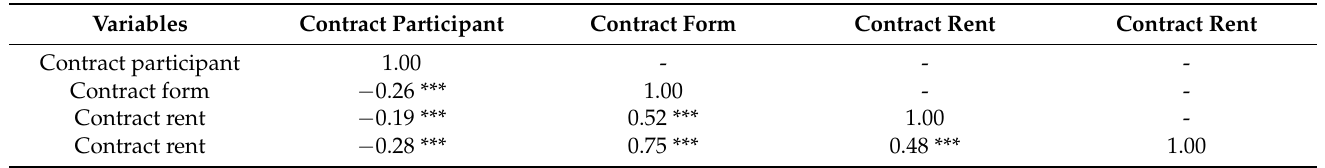
Table A1. The correlation analysis of characteristics of contract choice.